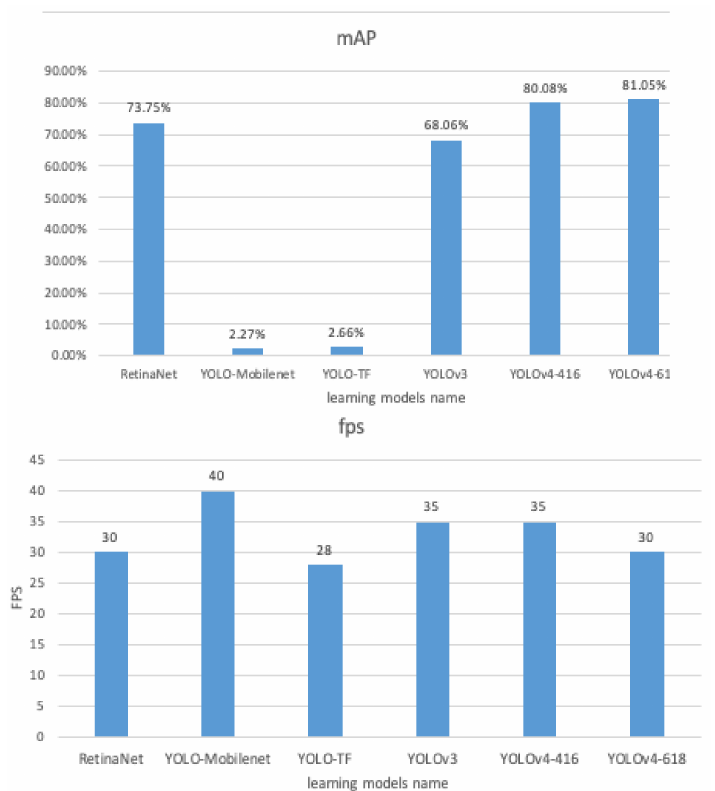
Figure 13. Quantitative comparison of mAP and FPS for different deep learning models.